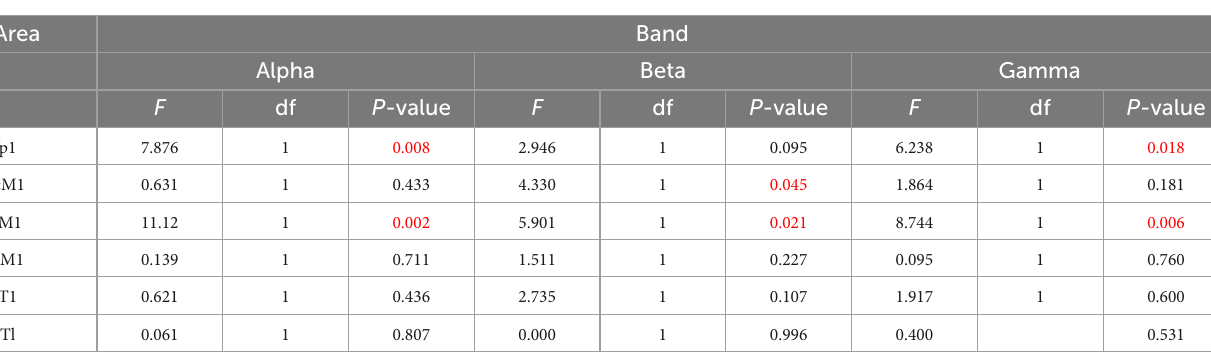
TABLE 3 The statistical analysis result of